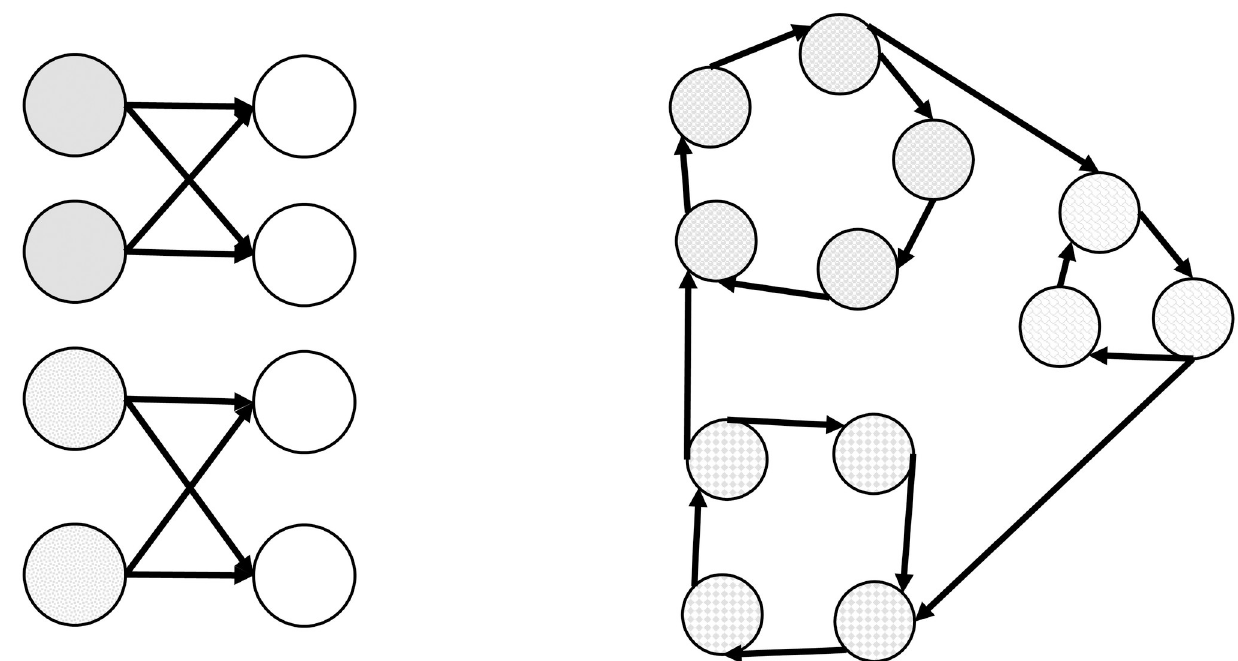
Fig 1. Citation-based cluster and flow-based